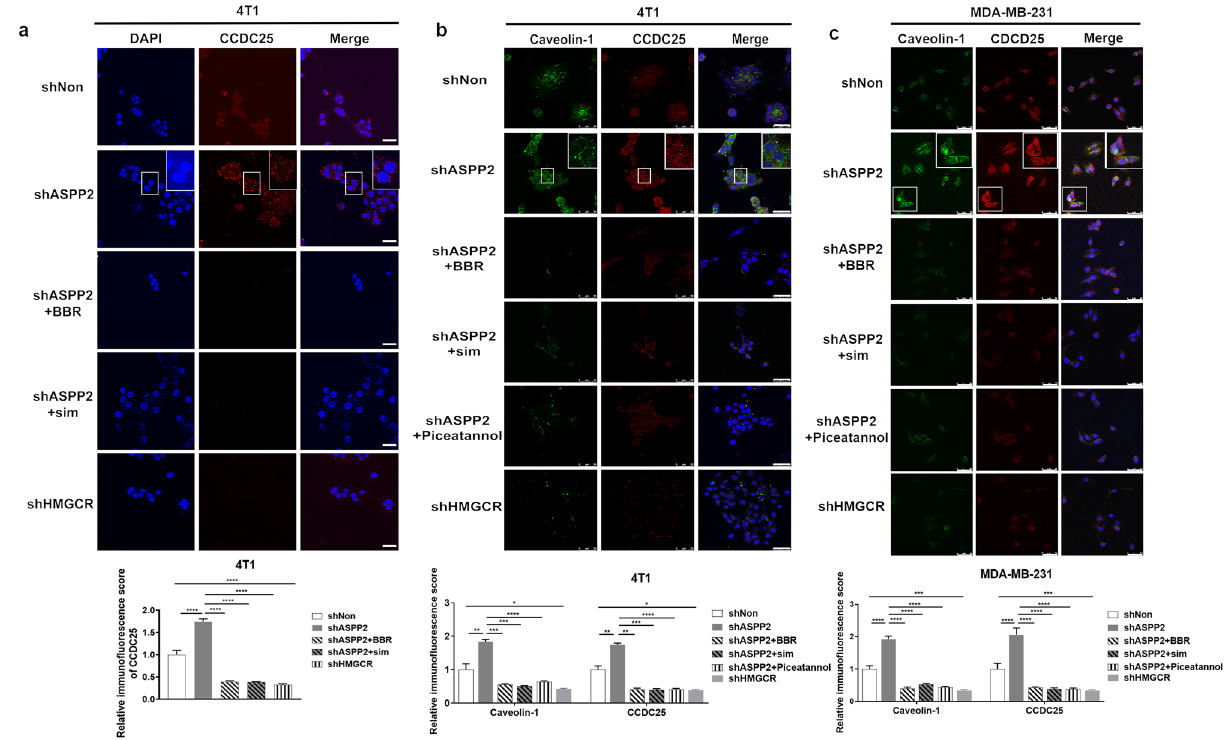
in the insets in the top right. Piceatannol was used to inhibition lipid rafts formation. Scale bar: 50 µm. Relative immunofluorescence scores were calculated and statistically analyzed. * P < 0.05; ** P < 0.01;*** P <